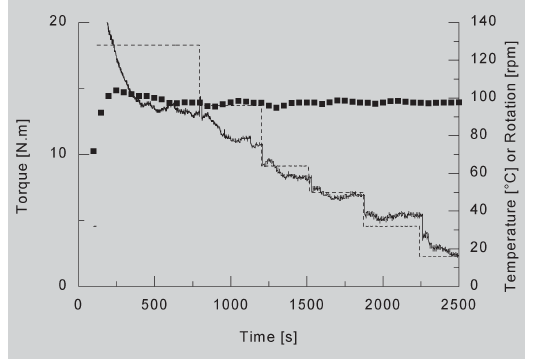
Figure 2 (left): Typical experiment for a 30 % moisture sample at 97.5 °C. Symbols indicate temperature variation, dashed line indicates rotation speed and full line is the torque measurement. Rotation speed between 16 and 128 rpm were investigated. Figure 3 (right): Comparison of the data of the capillary rheometer (full line) and Rheomix for a HDPE at 150 °C ( (cid:2) ) and a poly- carbonate at 220 °C (O) using the set of calibration parameters of Eq.